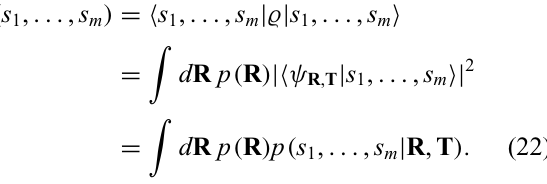
Algorithm: To sample from a state given by covariance matrix V and vector of means